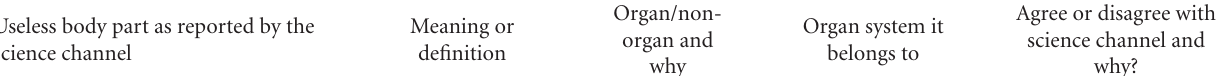
Table 6: 10 useless body parts as reported by the science channel.